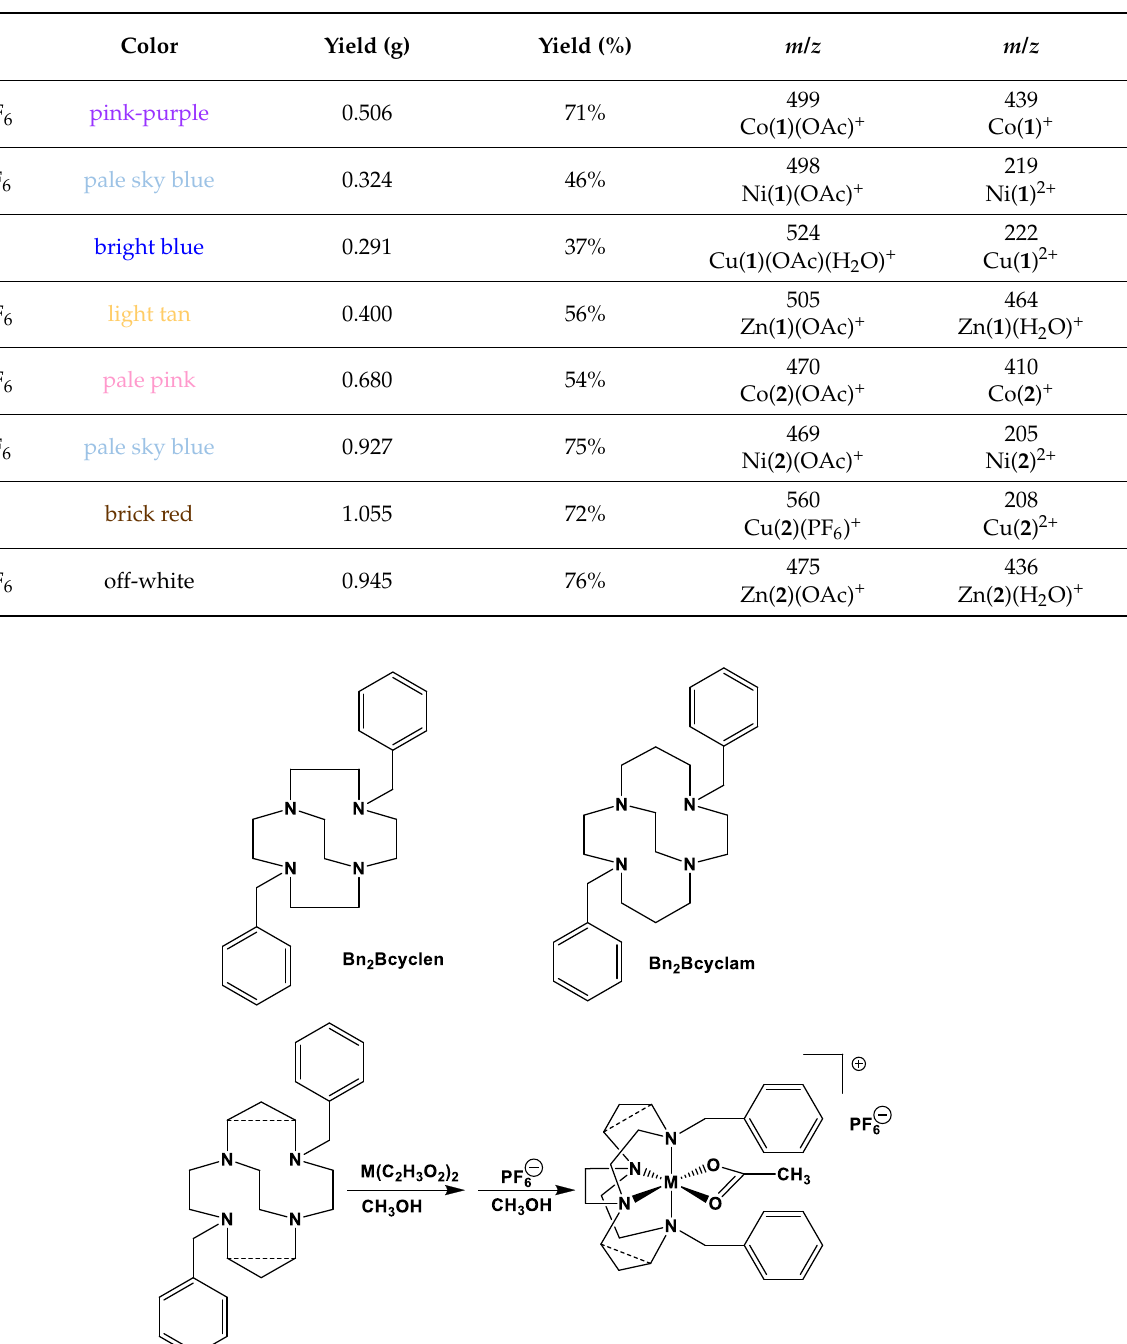
Table 1. Yields and selected peaks in the electrospray mass spectra of ligand 1 and 2 complexes.